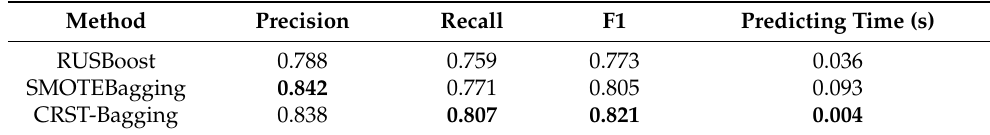
Table 4. The experimental results of RUSBoost, SMOTEBagging and CRST-Bagging on the test set. Method Precision Recall F1 Predicting Time (s)